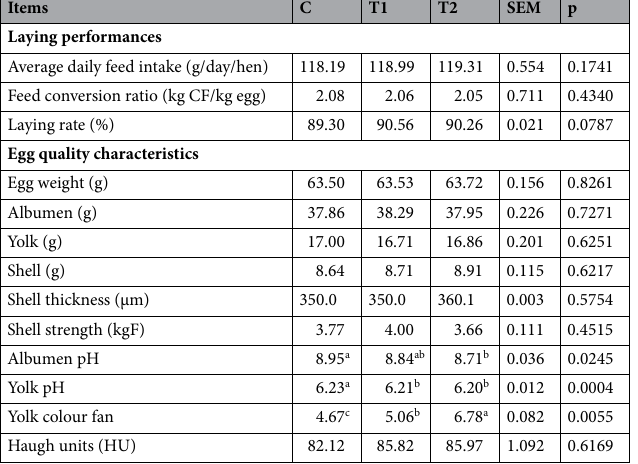
Table 1. Effect of dietary by-products on laying performances and egg quality characteristics. C control diet, T1 control diet with 9% rapeseed meal and 3% grapeseed meal, T2 control diet with 9% flax meal and 3% buckthorn meal, SEM standard error of the mean, p significance. abc Mean marked with a different superscript letter within each column are significantly